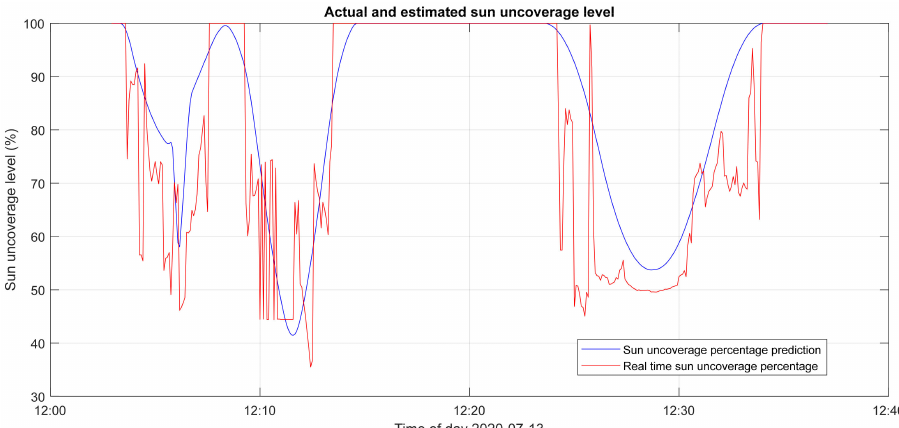
Figure 14. Comparison of real-time sun un-coverage and predicted level of sun un-coverage on 13 July 2020 from 12:00 until 12:40.